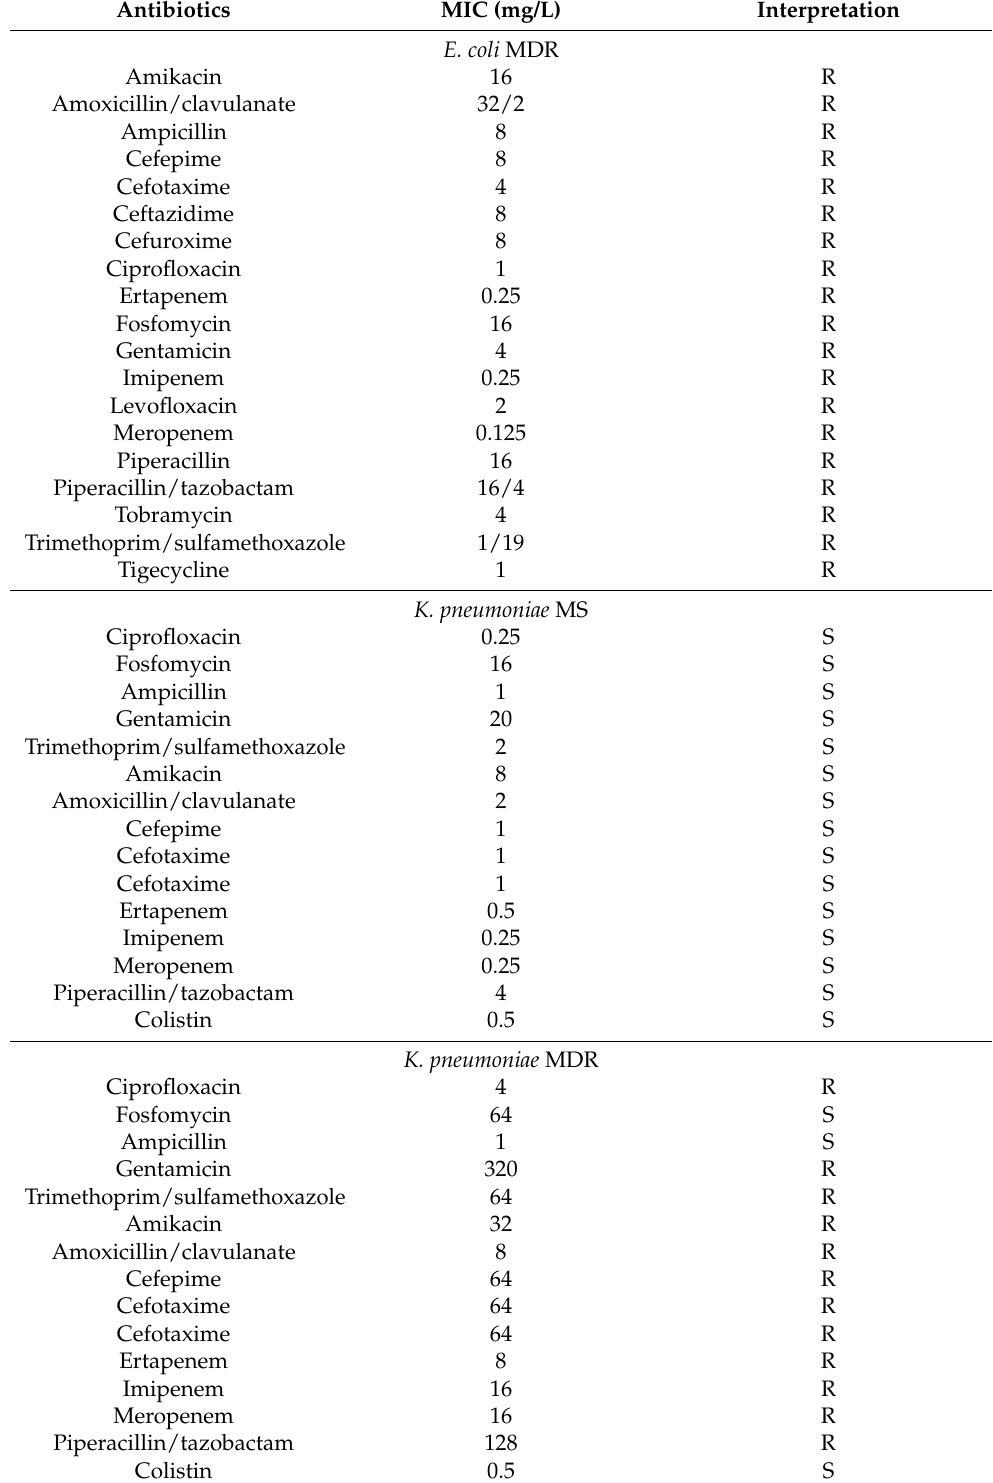
Table 2. Cont. Antibiotic Resistance Profile of the Clinical Isolated